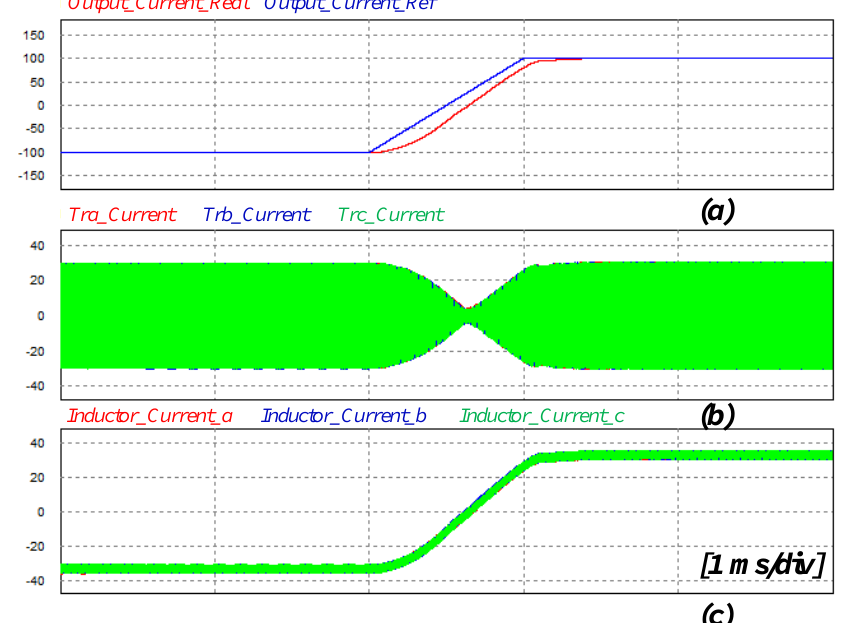
Figure 14. Simulation results of charging and discharging operation ( a ) real output current and reference output current, ( b ) three phase transformer current of the secondary side, and ( c ) three phase inductor current.